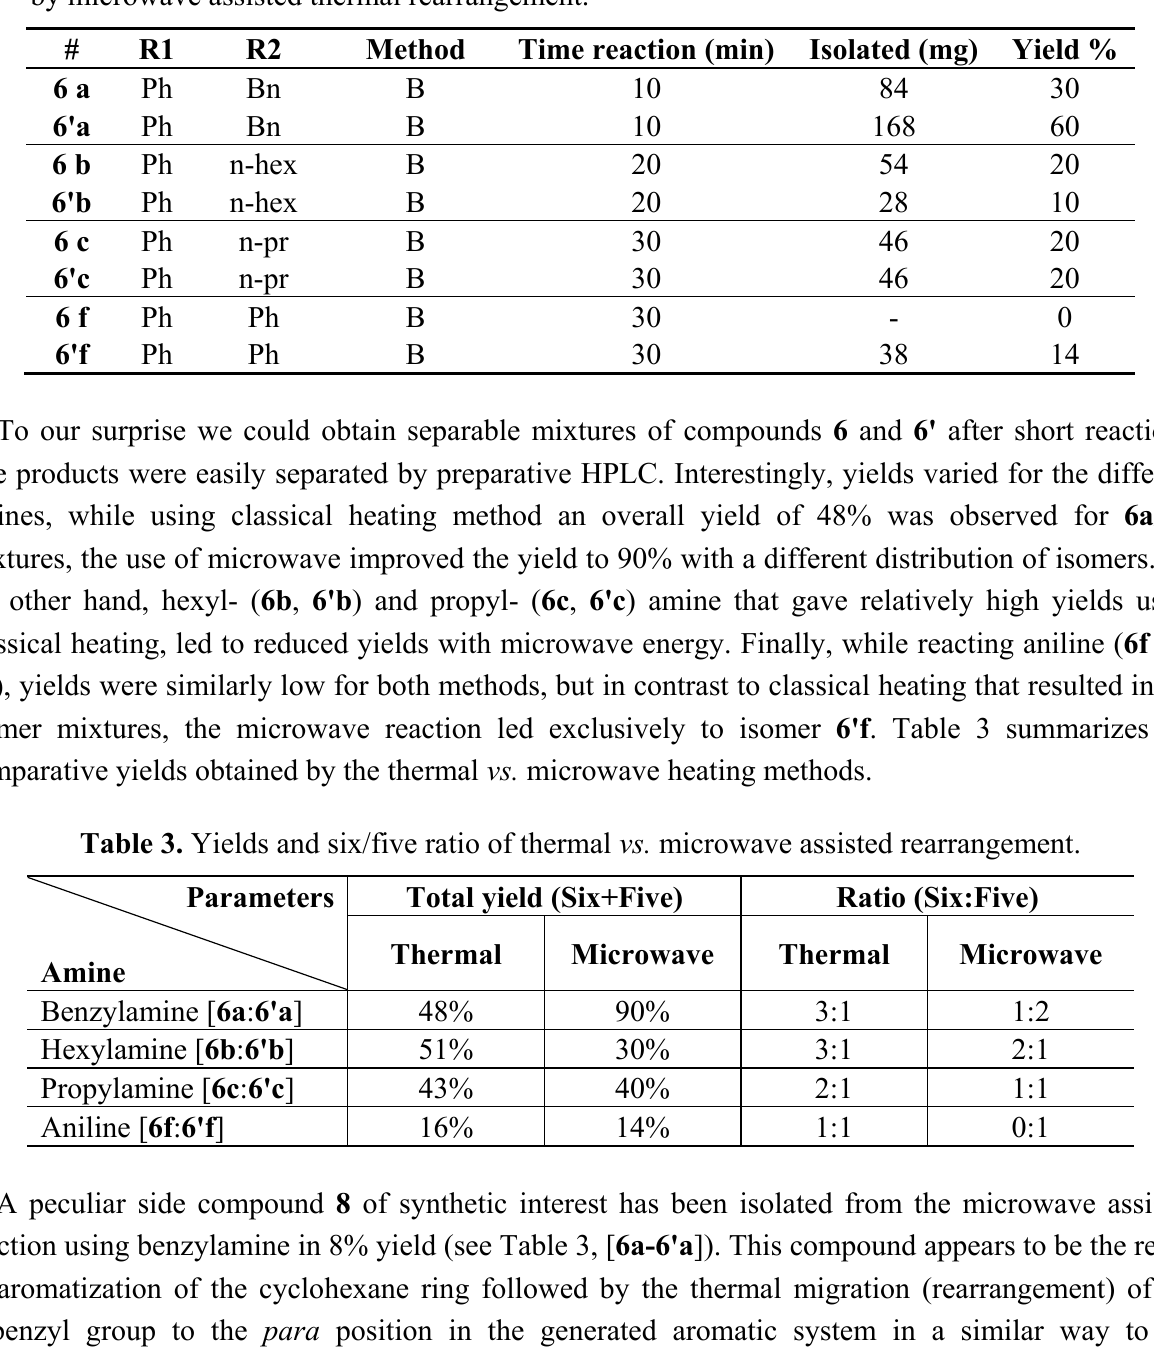
Table 2. Synthesis of selected six and five member ring compounds analogues of ketamine by microwave assisted thermal rearrangement.